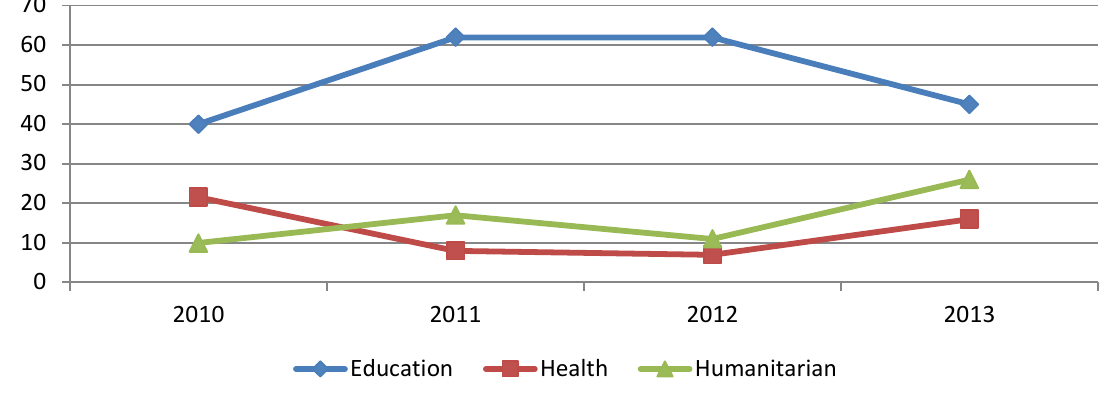
Figure 3. Sector wise expenditures on CSR (in percentage) by